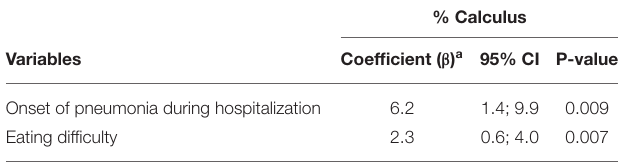
TABLE 3C | Mixed effect regression model comparing calculus with systemic findings.